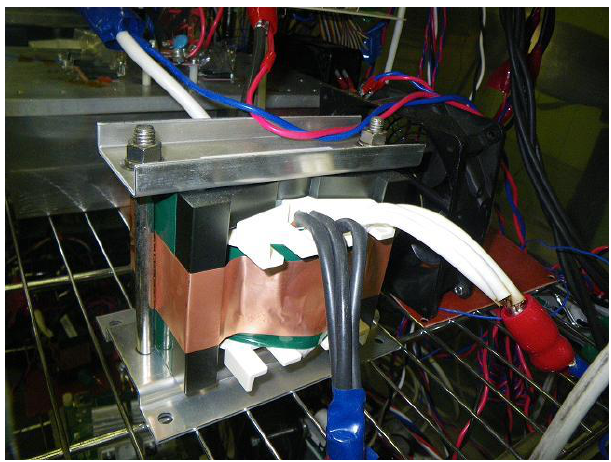
Figure 8. The high-frequency transformer used in the studied DC–DC converter.